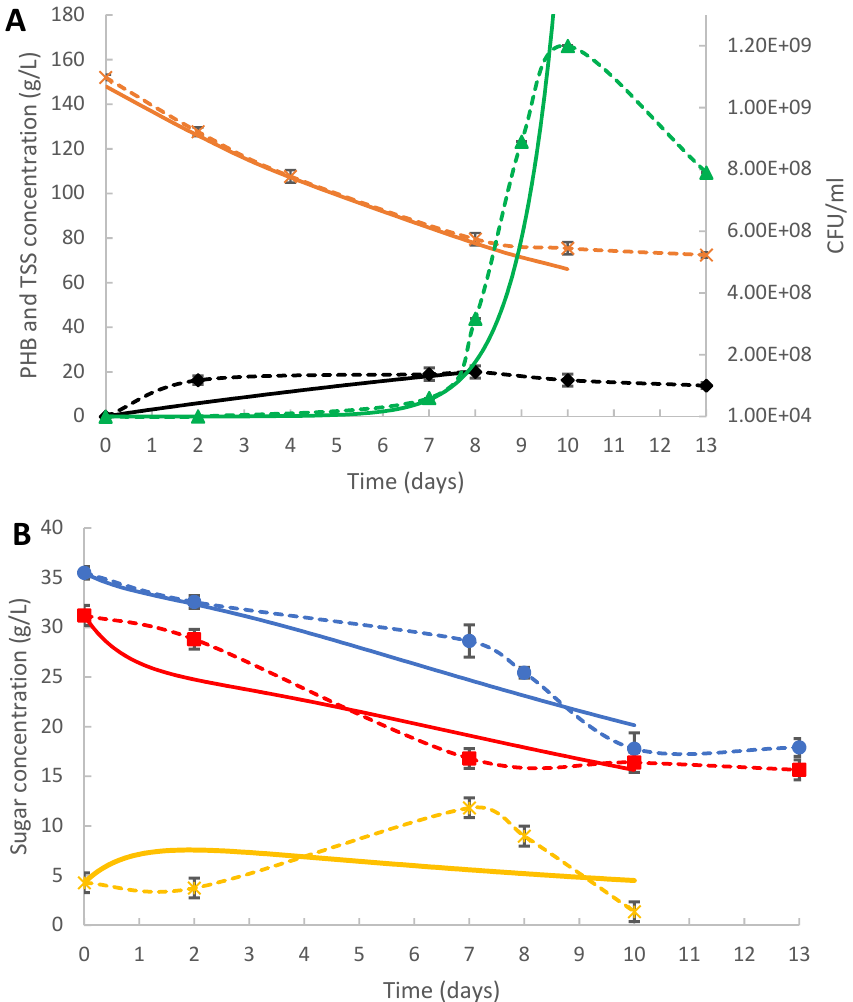
Figure 4. Evolution of ( A ) the concentration of TSS (x), PHB ( ♦ ), and bacteria viability ( ▲ ), and ( B ) the concentration of total sugars ( ● ), reducing sugars ( ■ ), and non-reducing sugars (*) during fer- mentation of the non-centrifuged medium obtained from CBS hydrolyzed at 135 °C for 10 min. The symbols and dashed lines correspond to experimental data and continuous lines correspond to model results.